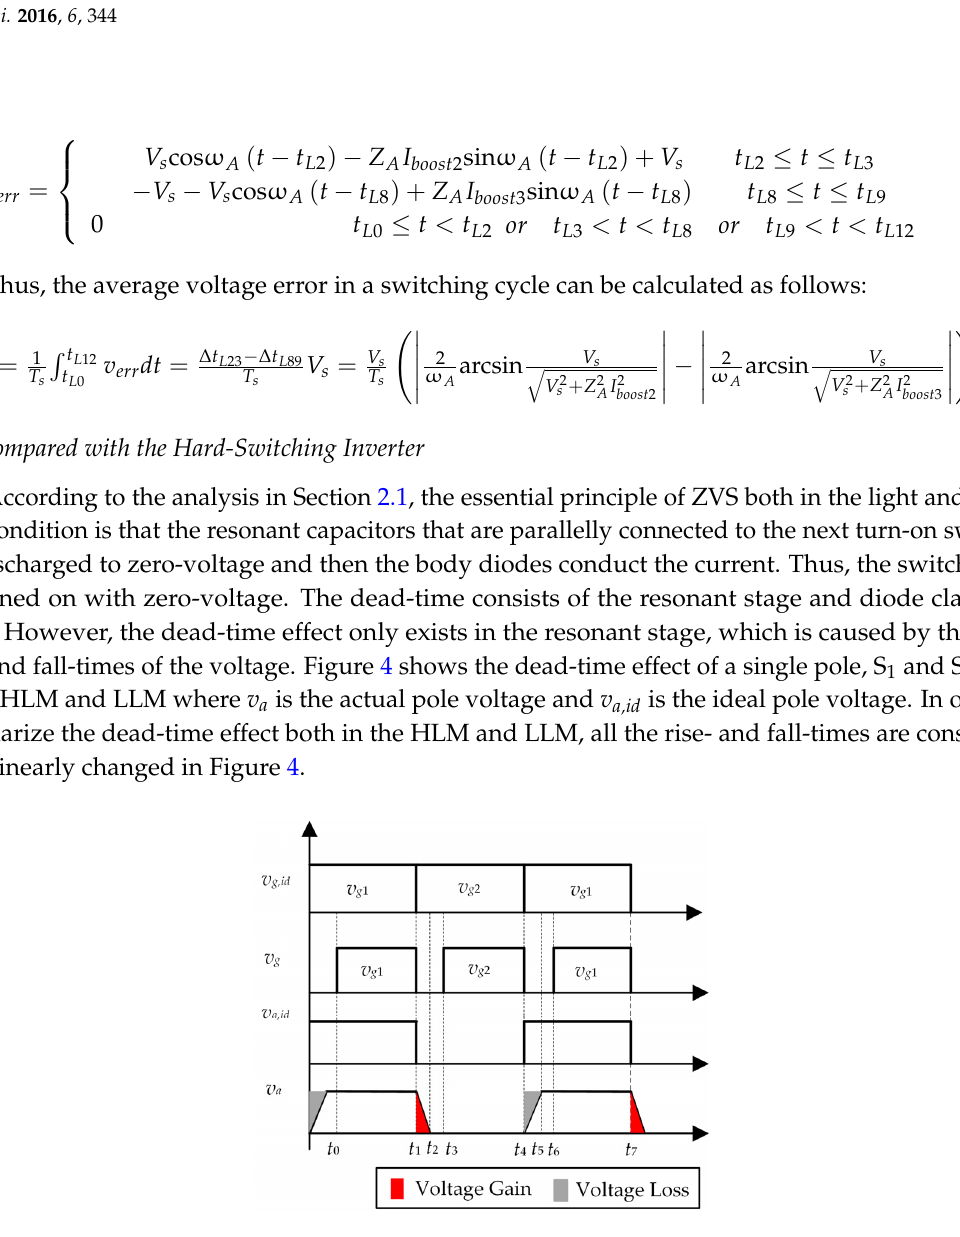
Figure 4. Dead ‐ time effect of the ARSI. Figure 4. Dead-time effect of the